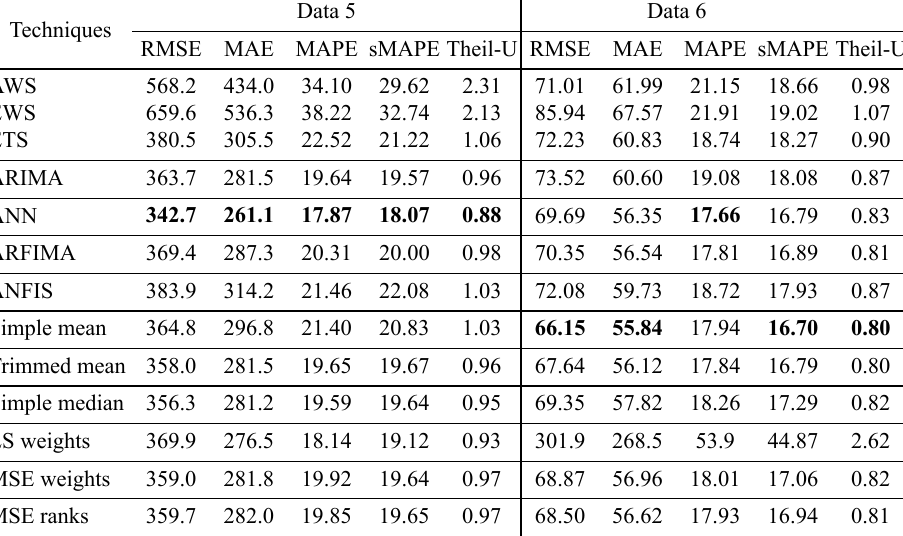
Table 6. Forecasting results of the single models and combining methods for Data 5 and 6 Data Techniques